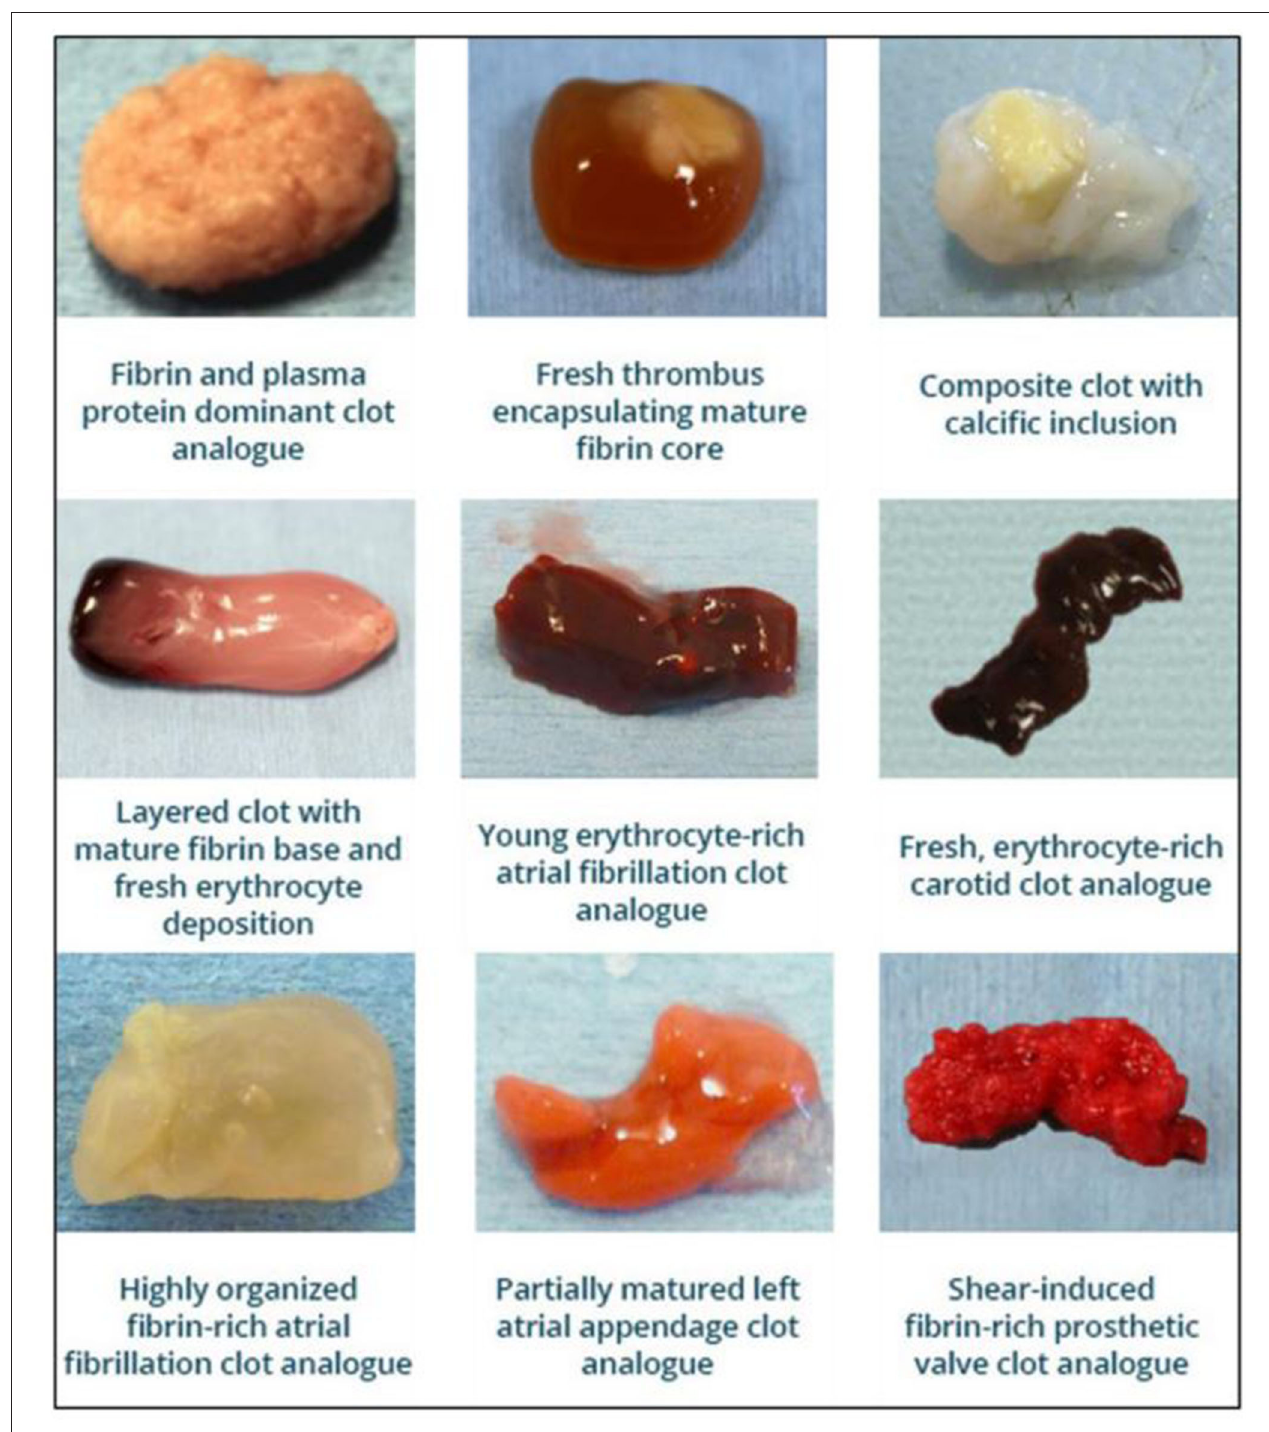
FIGURE 4 | Image of range of clots analogues produced for device testing in in-vitro models.